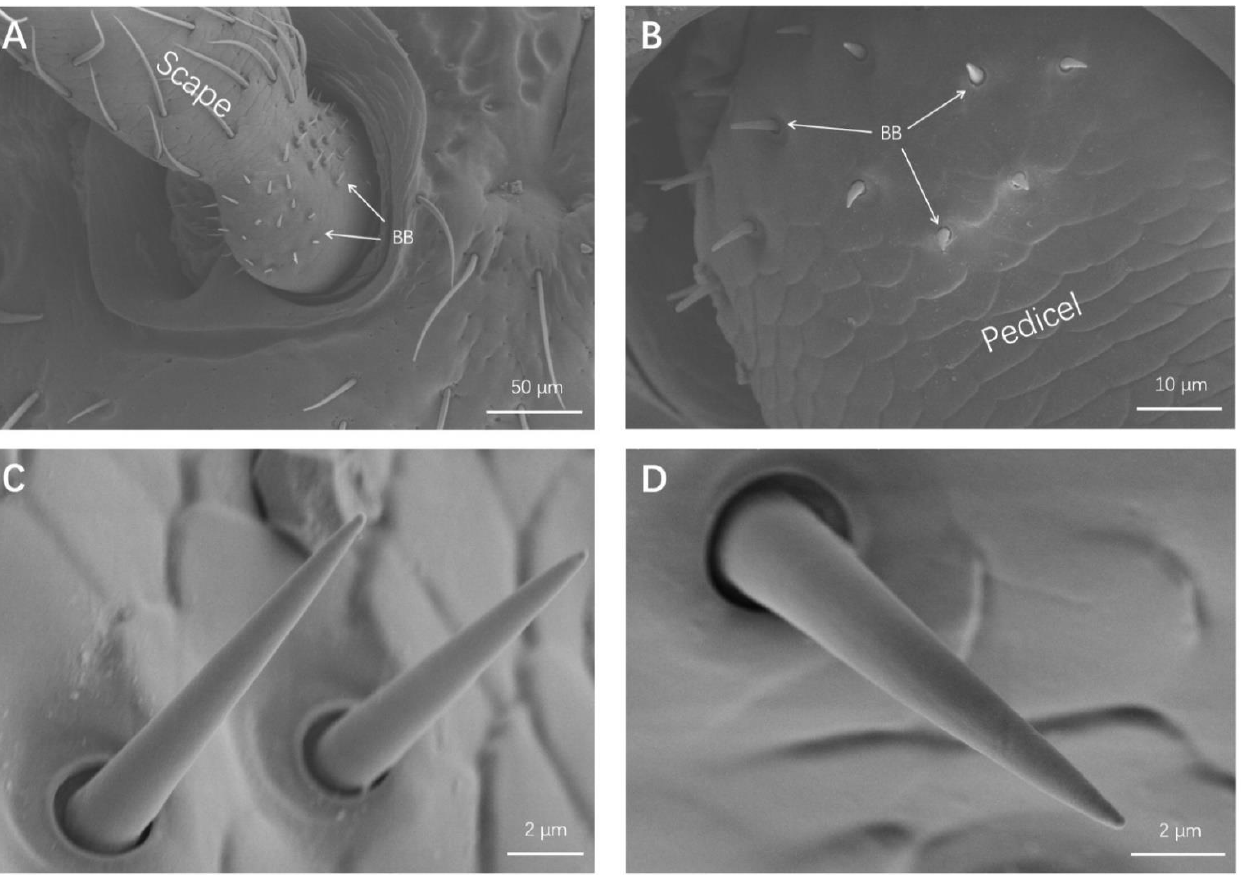
Figure 4. Details of sensilla Böhm bristles (BB). ( A ) BB on the joint membranes between the head and the scape. ( B ) BB on the joint membranes between the scape and the pedicel. ( C ) Magnification of BB on the scape. ( D ) Magnification of BB on the pedicel.